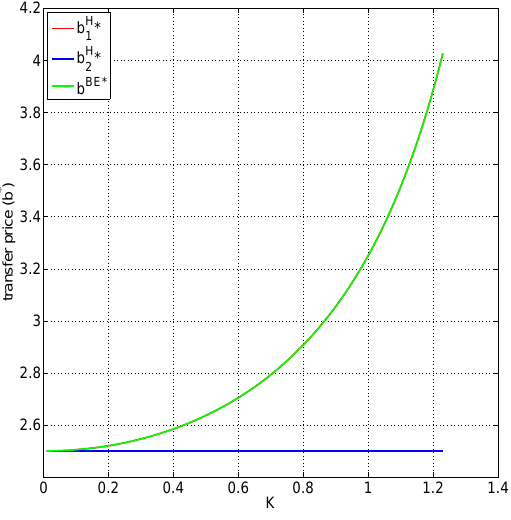
Figure 5. The influences of K on the transfer price b